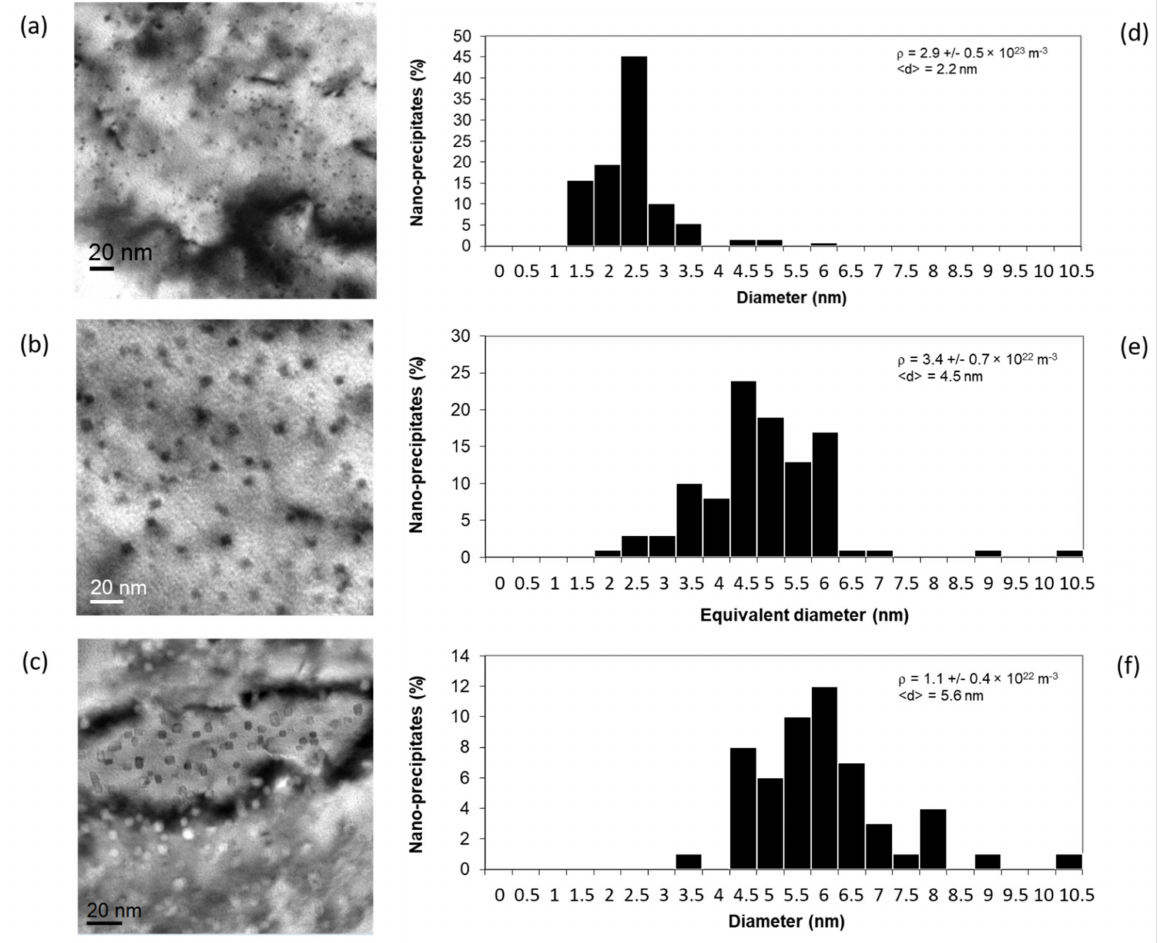
Figure 3. Bright field TEM image with its corresponding histogram: ( a , d ) as-received material, ( b , e ) after thermal annealing (1300 ◦ C, 1 h), ( c , f ) after irradiation up to 150 dpa at 500 ◦